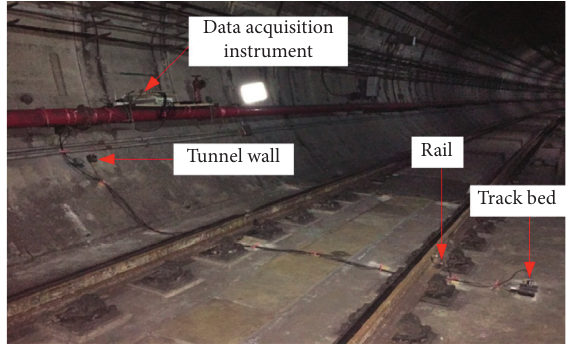
Figure 4: In-situ arrangement of accelerometers in the tunnel.